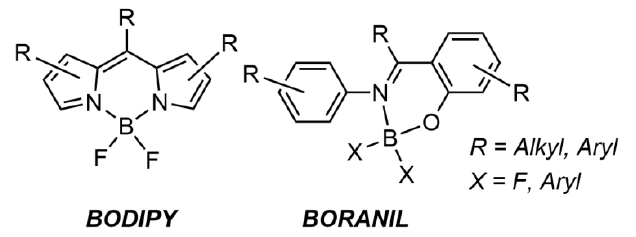
Figure 1. Structures of BODIPY and boranil